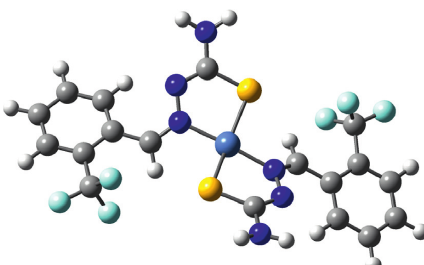
Figure 1: Optimized molecular structure of NiL